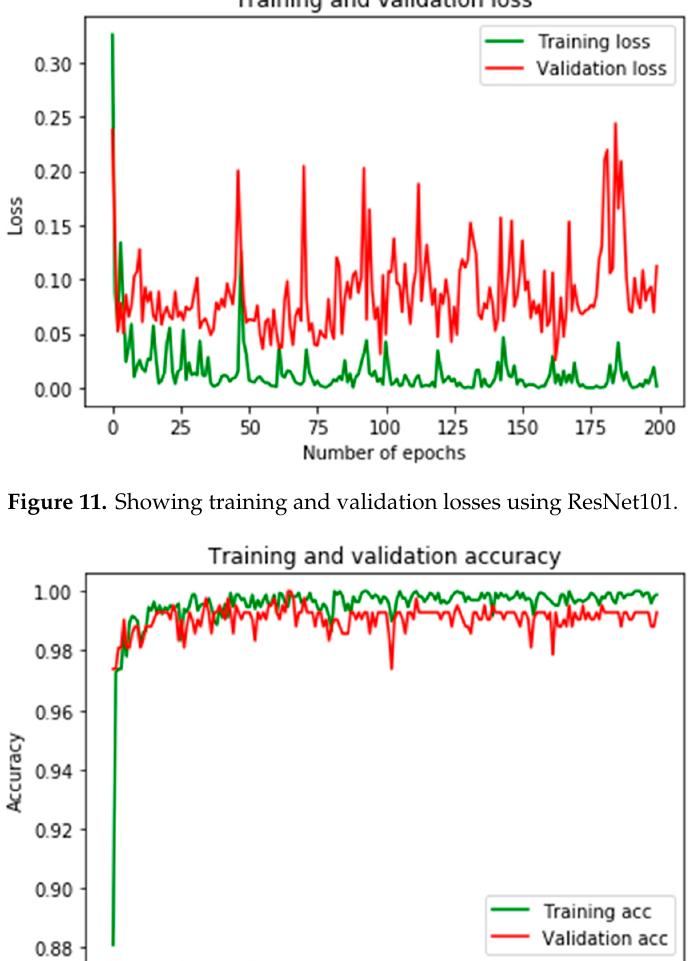
Appl. Syst. Innov. 2020 , 3 , x FOR PEER REVIEW Figure 12 . Showing training and validation accuracies using ResNet152 . Figure 12. Showing training and validation accuracies using ResNet152.